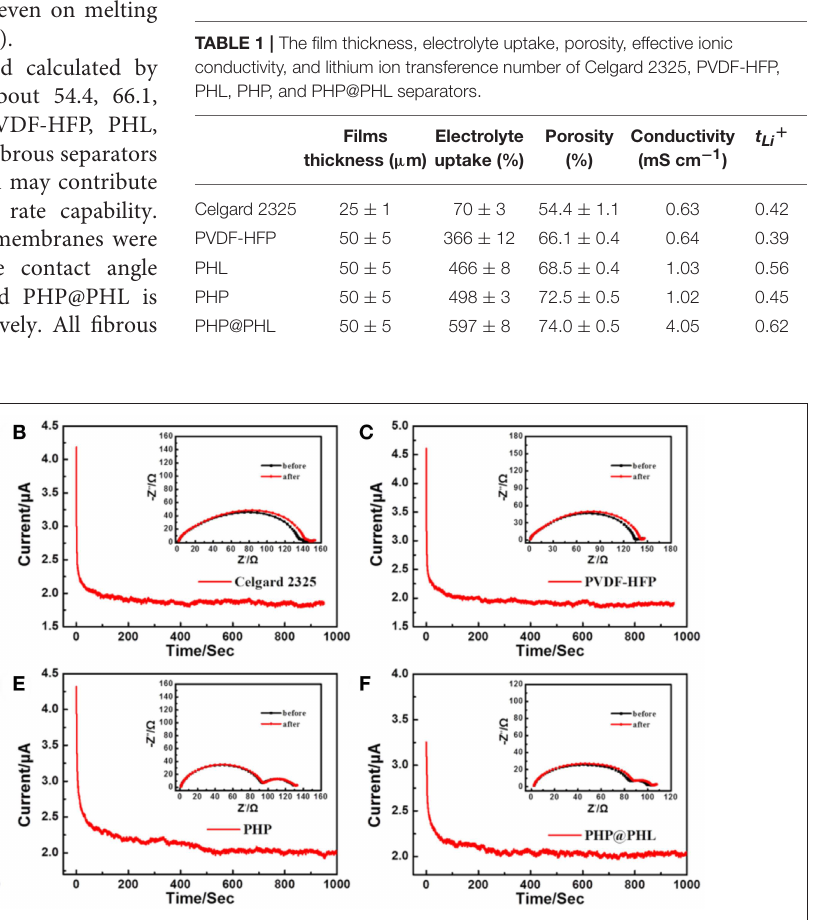
FIGURE 3 | (A) Nyquist plot of AC impedance measurements (SS/separator/SS) of the Celgard 2325, PVDF-HFP, PHL, and PHP@PHL separators; Lithium ion transference numbers of (B) the Celgard 2325, (C) PVDF-HFP, (D) PHL, (E) PHP, and (F) PHP@PHL membranes as demonstrated by CA polarization curves and EIS plots before and after